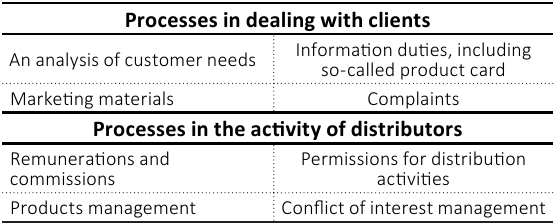
Table 1. Business processes that should be covered by changes within a new insurance distribution model